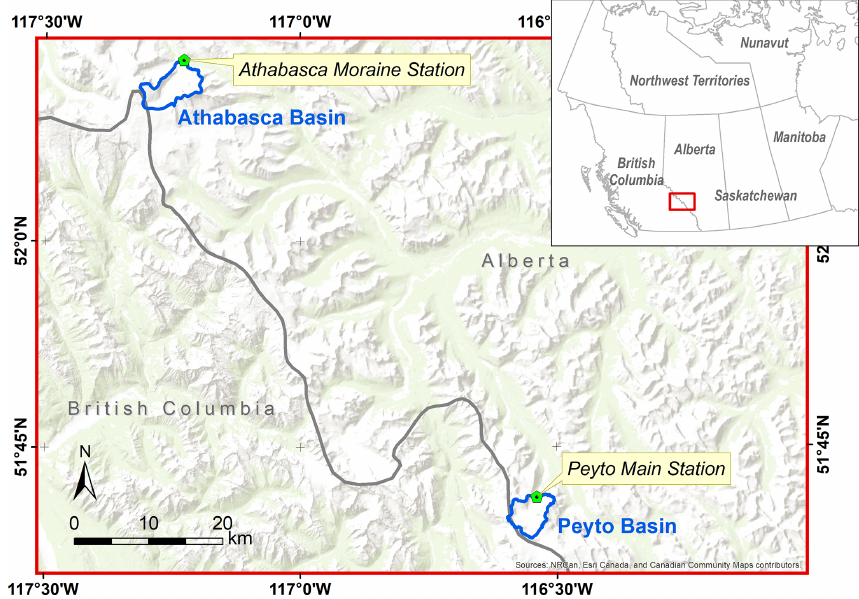
Figure 1. Location map of Peyto and Athabasca glacier research basins. The gray line is the border between two provinces, blue polygons are basin boundaries, and green pentagons are meteorological